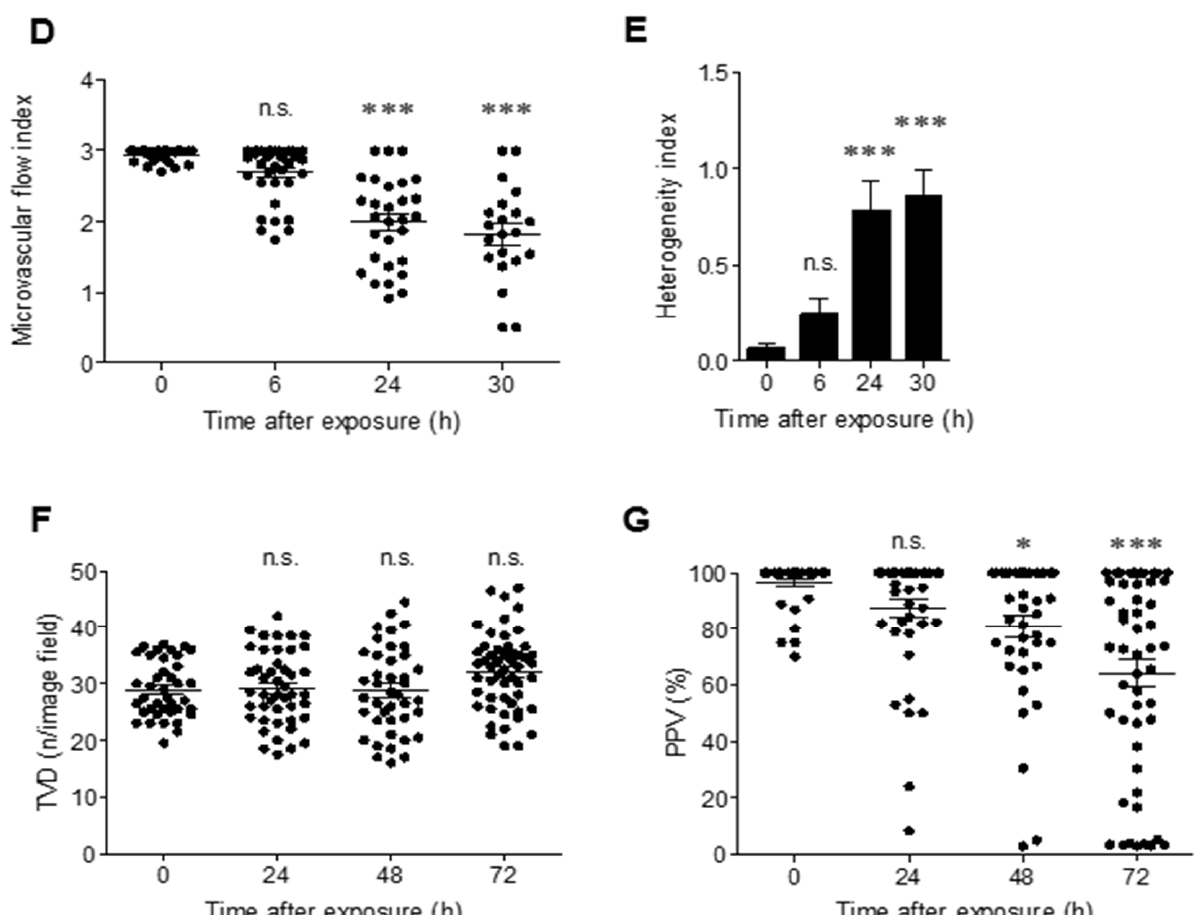
Figure 6. Measurement of microcirculation functionality in ricin-intoxicated swine and mice. ( A ) Representative SDF images of the sublingual microcirculation in swine before (control) or 30 h after ricin exposure (7.5 µ g/kg). The arrows indicate areas with impaired microvascular flow. Microcirculatory parameters TVD ( B ), PPV ( C ), MFI ( D ) and HI ( E ) were determined in swine before (0 h) or at the indicated time points after ricin exposure. ( n = 5 in each group; each dot represents data from an individual movie). TVD ( F ) and PPV ( G ) were determined in the cecum of mice before (0 h) or at the indicated time points after ricin exposure (18 µ g/kg) ( n = 5 in each group; each dot represents data from an individual movie). The results are depicted as means ± SEM. Statistical analyses were performed by one-way ANOVA followed by Dunnett’s post hoc test. * p < 0.05; *** p < 0.001; n.s., not significant.